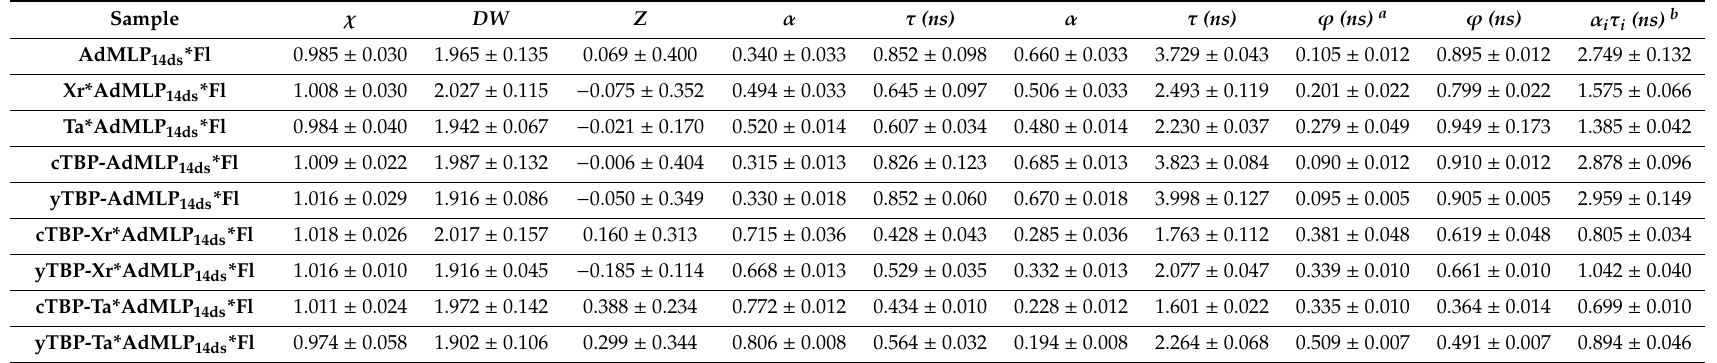
Table 5. Time-resolved FRET of the free duplexes and TBP bound to AdMLP 14ds *Fl, Xr*AdMLP 14ds *Fl, and Ta*AdMLP 14ds *Fl, at 20 ◦ C. All the decays were best described by a bi-exponential decay model according to the statistical parameters χ 2 , Durbin-Watson ( DW ), and Z run (Equation (21)).